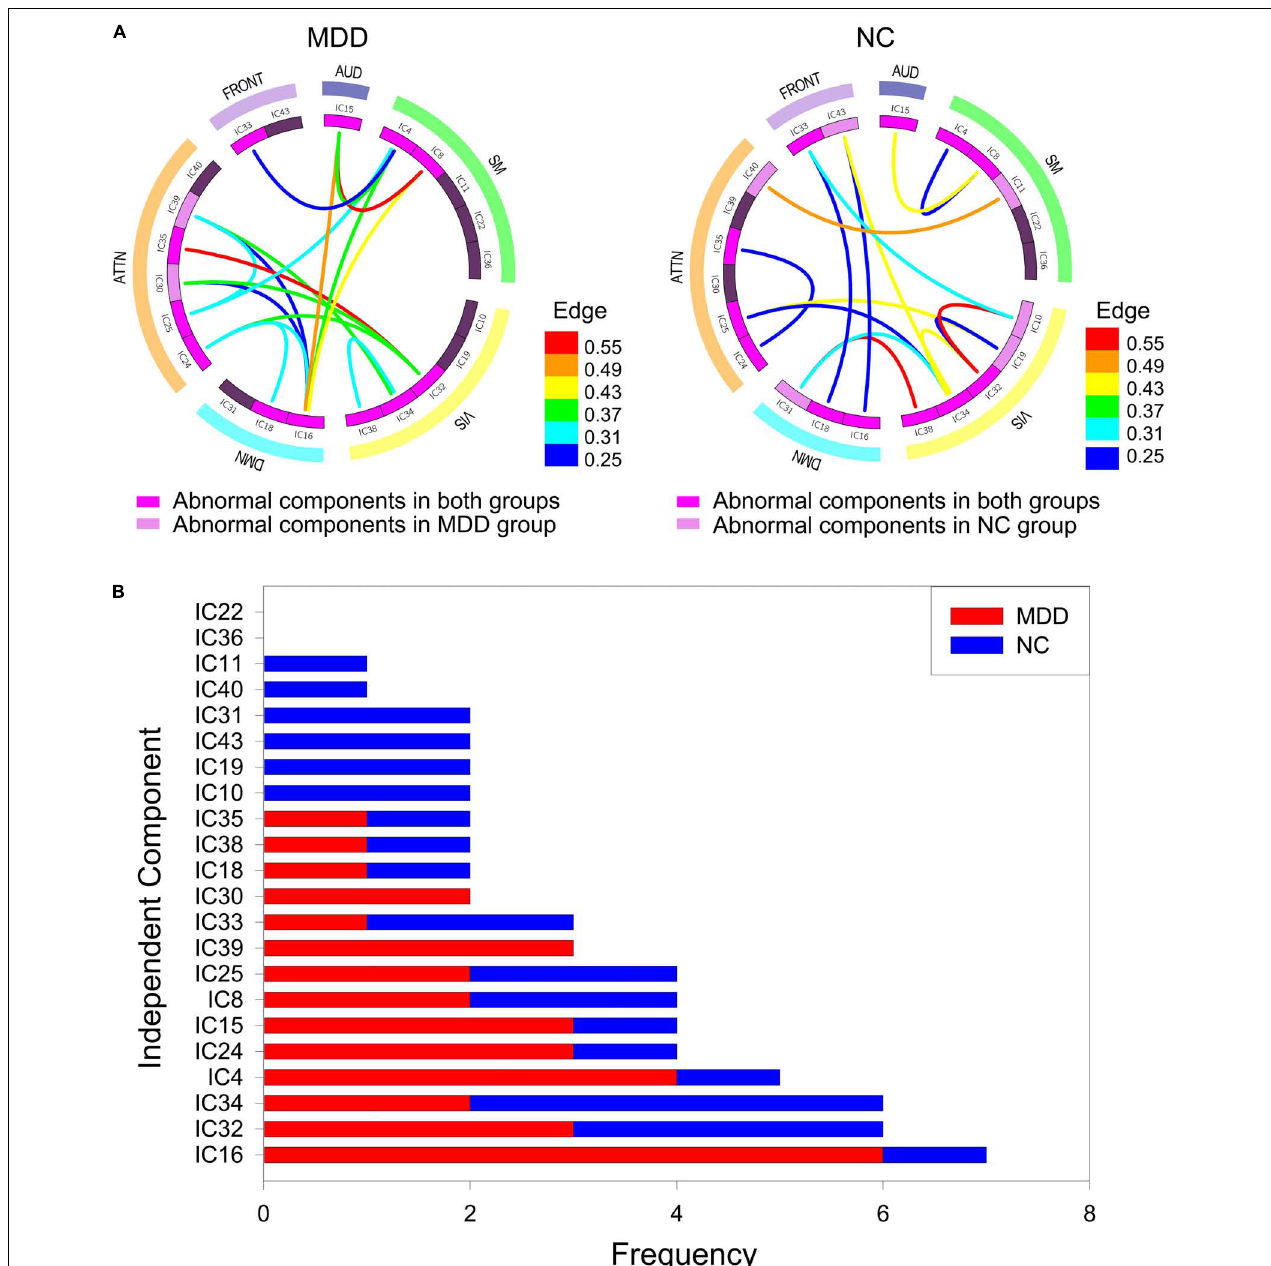
FIGURE 4 | The abnormal independent components of subgraph feature. (A) Represents all discriminative subgraphs were combined in each group. AUD, auditory network; SM, sensorimotor network; VIS, visual network; DMN, default mode network; ATTN, attentional network; FRONT, frontal network. Edge refers to the edges are assigned with a probability of existence. (B) Represents a statistical chart about the occurrences of these independent components in (A)